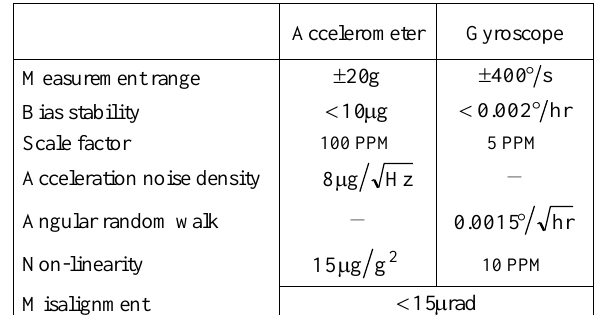
Figure 3. The exterior view and size of iNAV-RQH